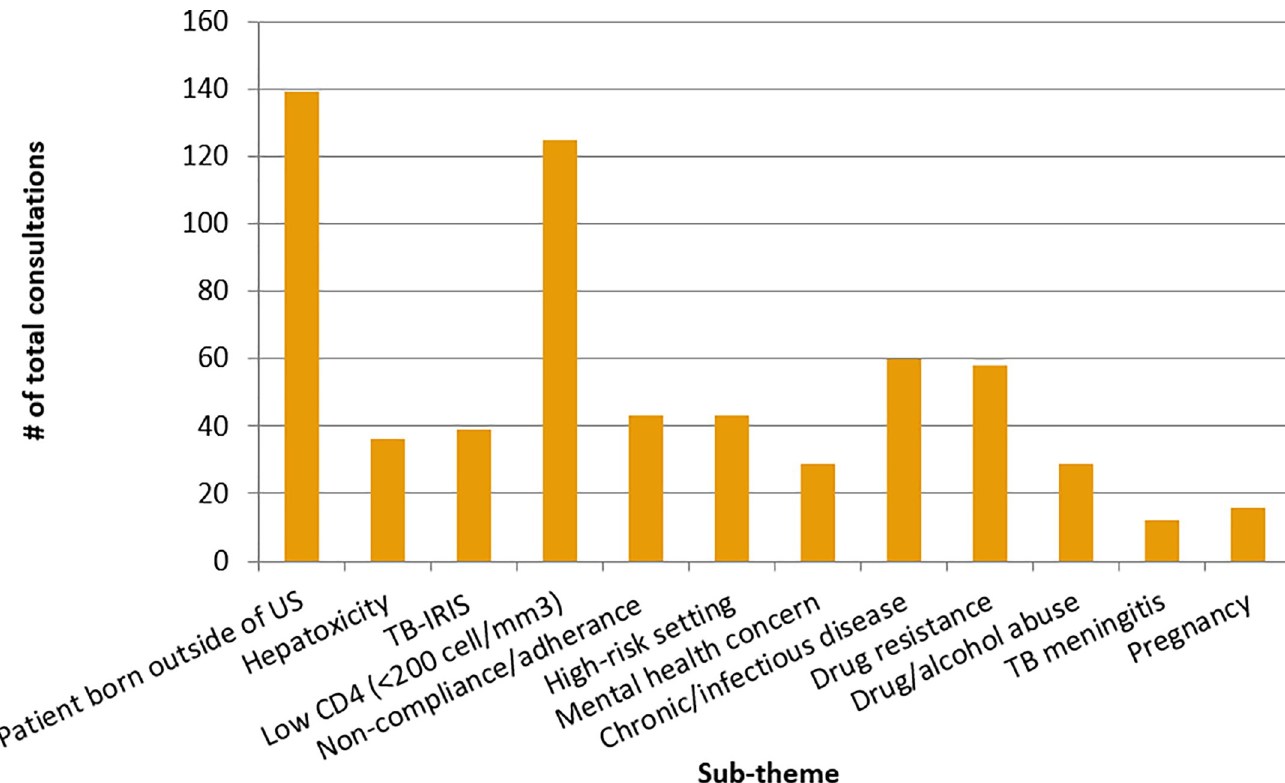
Fig 2. Sub-themes among consultation inquiries received by all Regional Training and Medical Consultation Centers (RTMCCs) between 1/1/13 and 12/31/ 17, not mutually exclusive. a. TB-associated immune reconstitution inflammatory syndrome. b. < 200 cell/mm 3 .